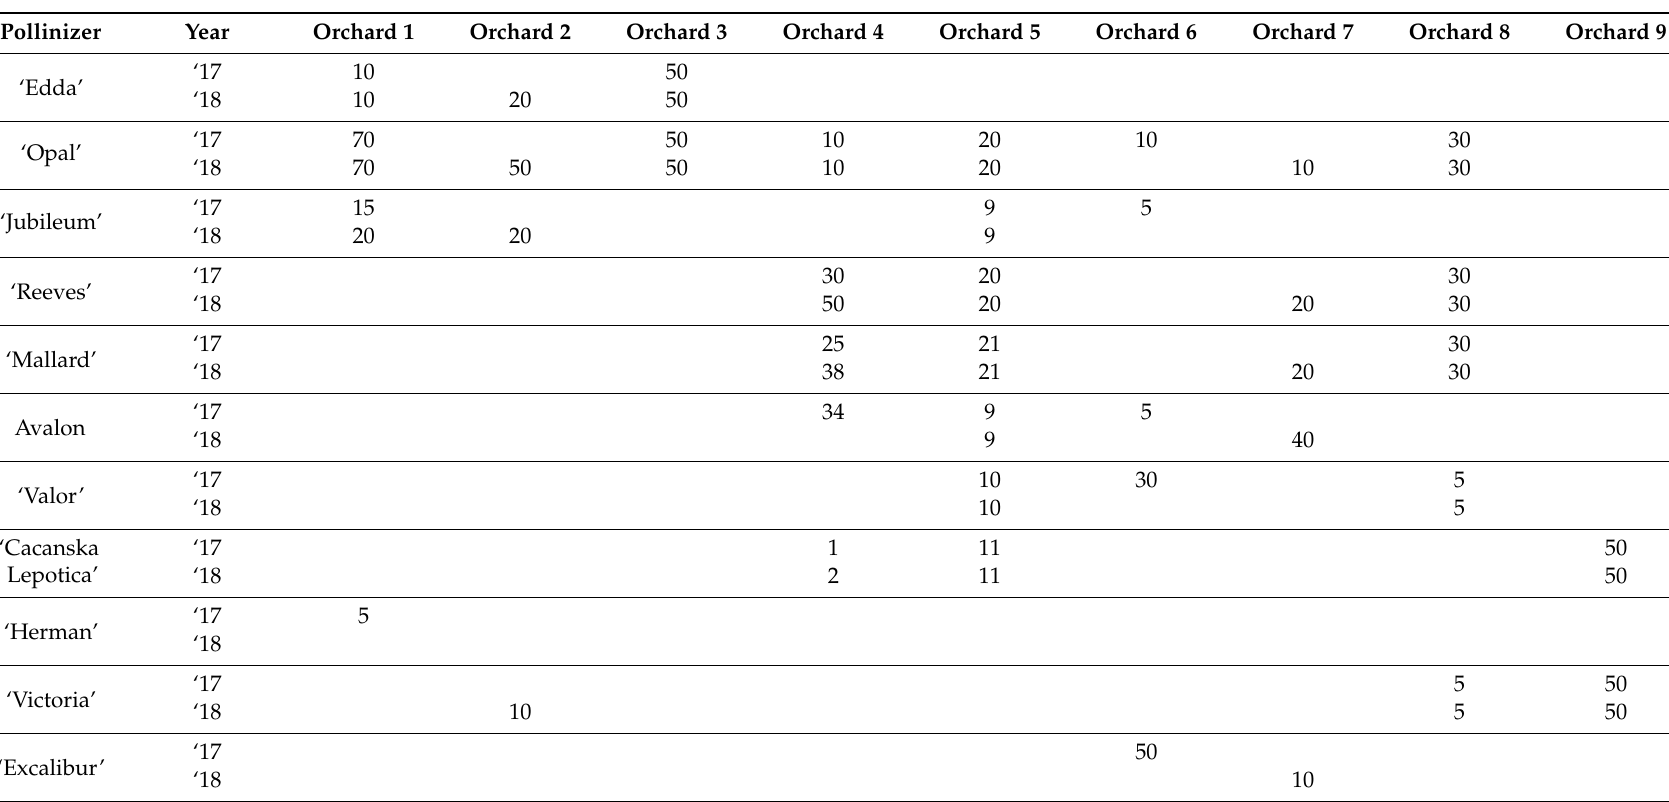
Table 2. The abundance of each main cultivar and pollinizer within the orchards sampled in this study, as well as within the adjacent sites (200 m radius from sampled trees), expressed in percentage of the overall number of